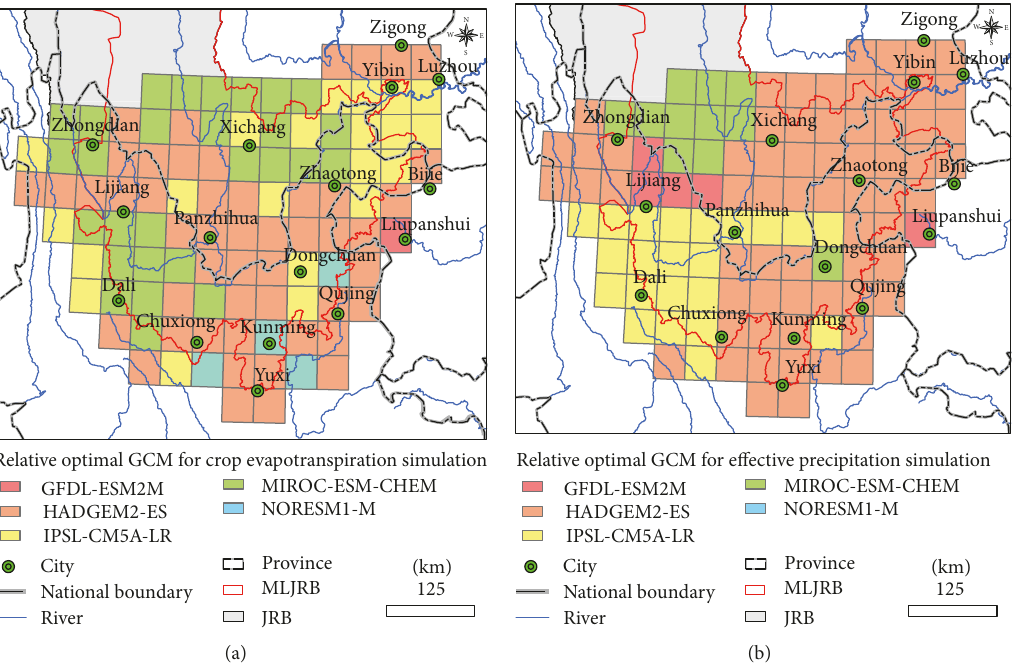
Figure 14: Spatial distribution of relative optimal climate models.